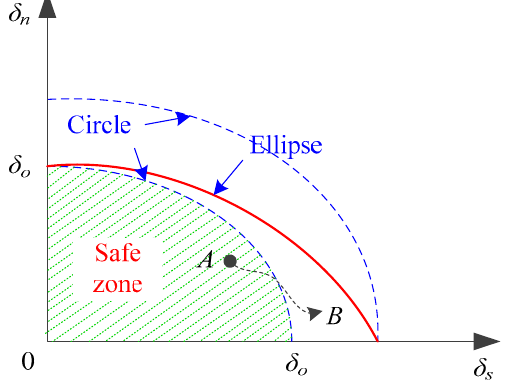
Figure 5. Schematic of fracture initiation criterion and the change of the mixed-mode ratio.